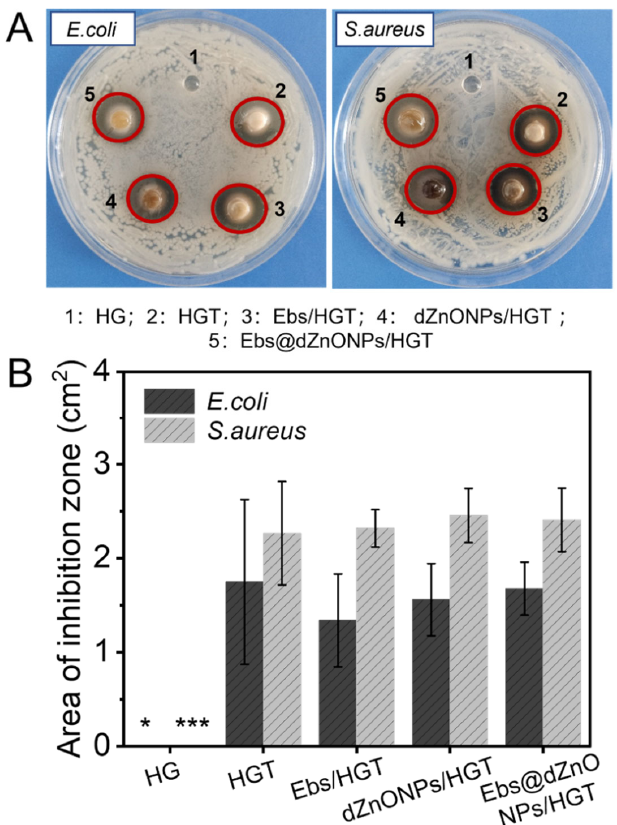
Figure 4. ( A ) Bacteriostatic zone testing of hydrogels; ( B ) Quantitative analysis of the zone of inhibition. Data are presented as mean ± standard ( n = 3), * means p < 0.05, *** means p < 0.001.